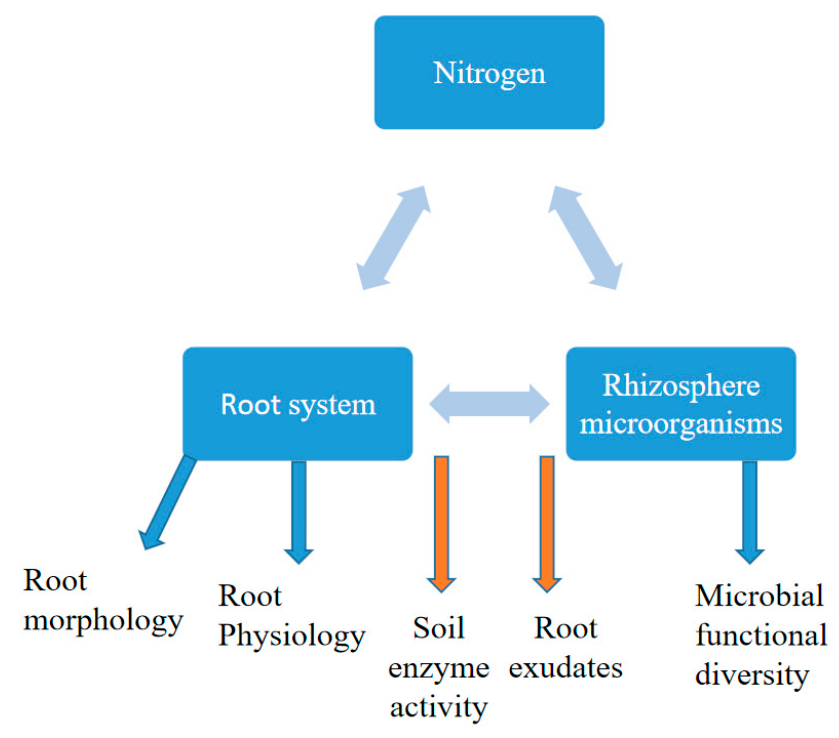
Figure 2. The relationship among nitrogen and root system, rhizosphere microorganisms.